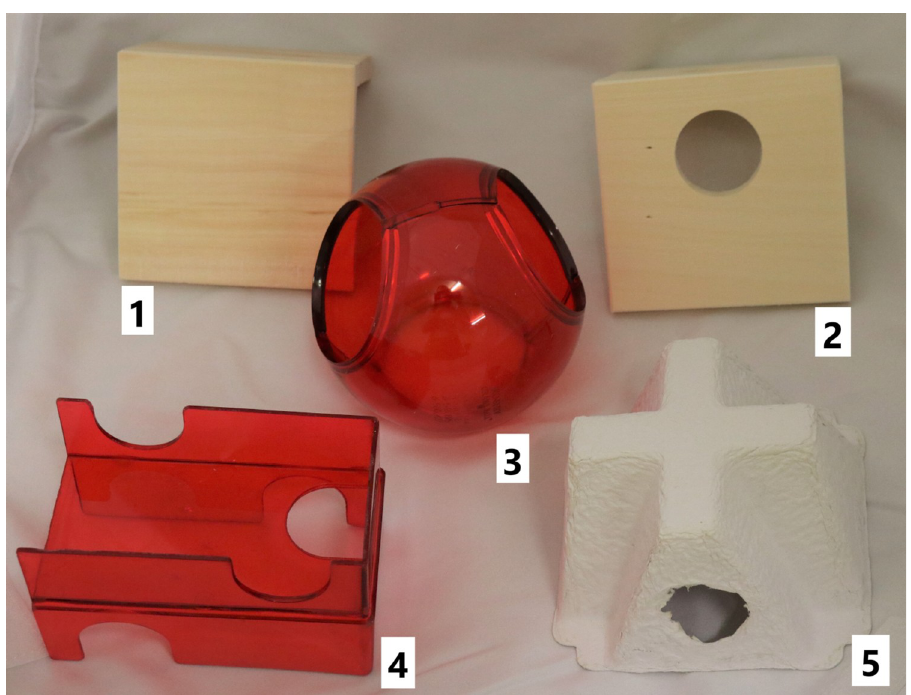
Fig 3. Enrichment items from the category housing. 1 wooden angle, 2 wooden angle with hole, 3 house ball 4 floor house 5 paper house.